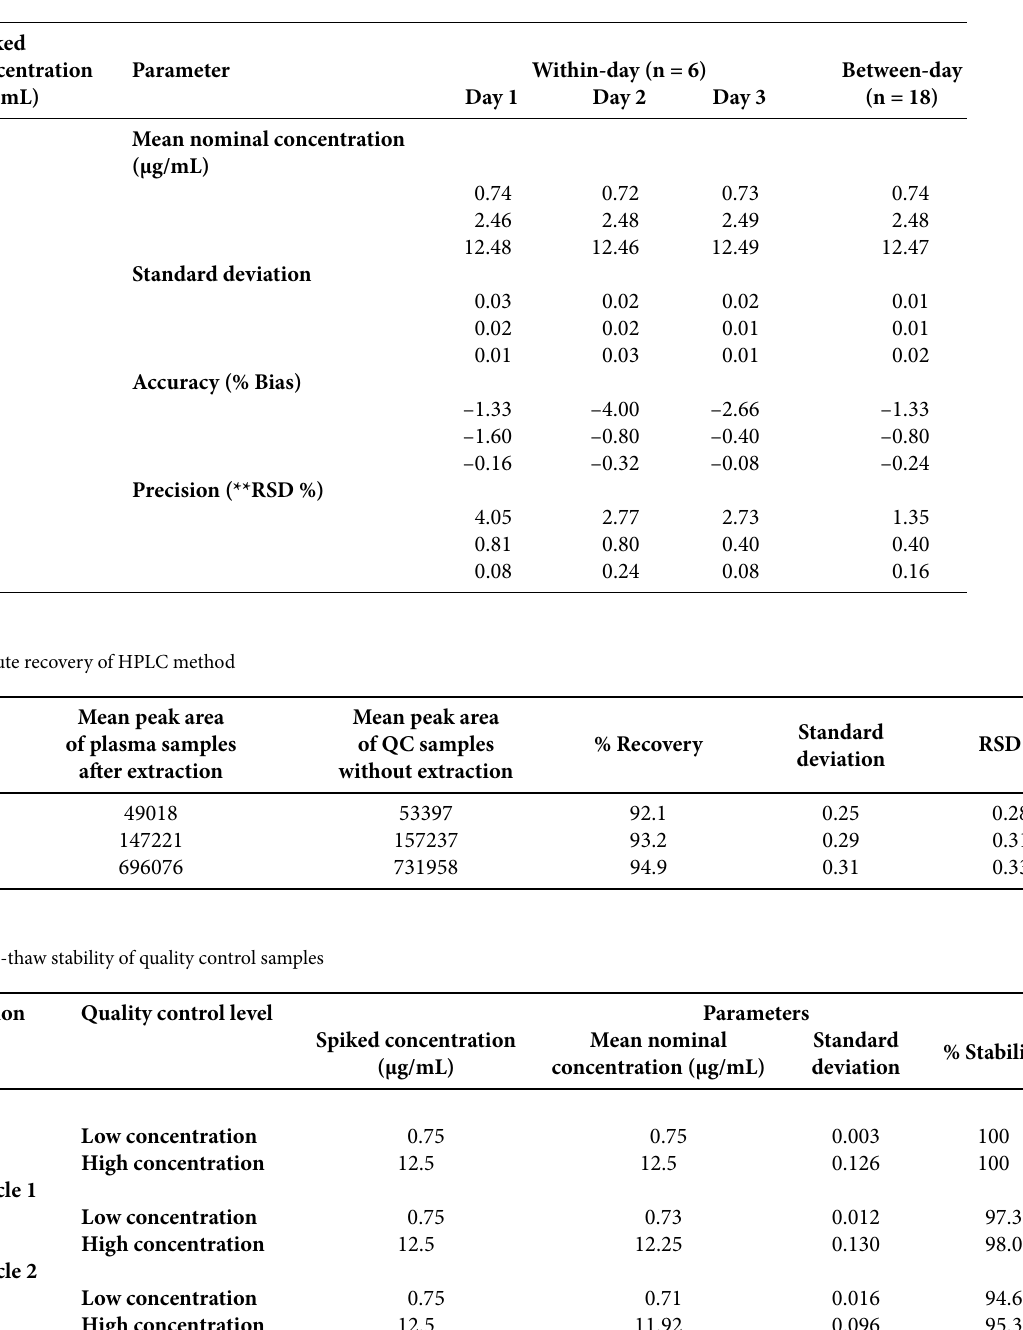
Table 2. Within-day and between-day accuracy and precision of analytical assay